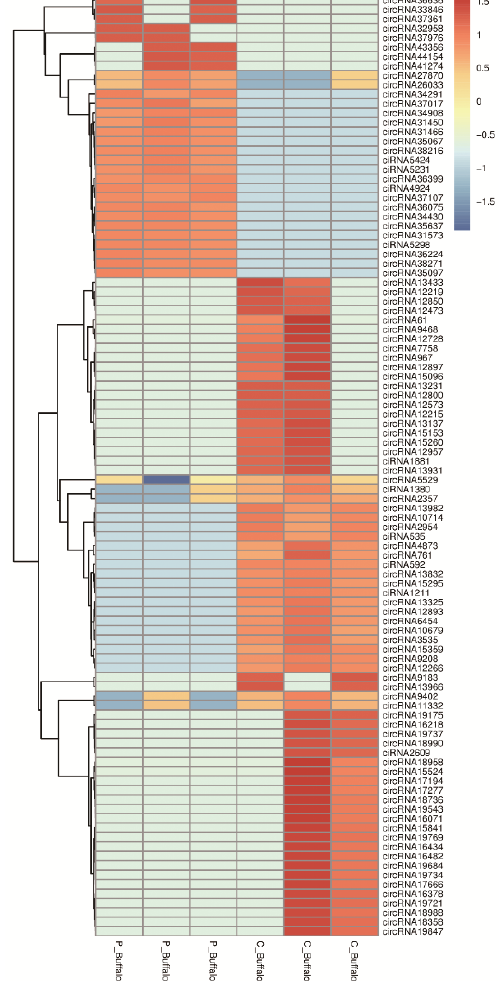
Figure 3. Heatmap of DECs in blood between C-Buffalo and P-Buffalo. Heatmap indicating the expression profiles of DECs in P-Buffalo and C-Buffalo. Red areas indicate up-regulated circRNAs whereas blue areas show down-regulated circRNAs. Heatmap color bars stand for expressed levels, with lightest blue representing − 1.5 log2 fold change and darkest red representing 1.5 log2 fold change.